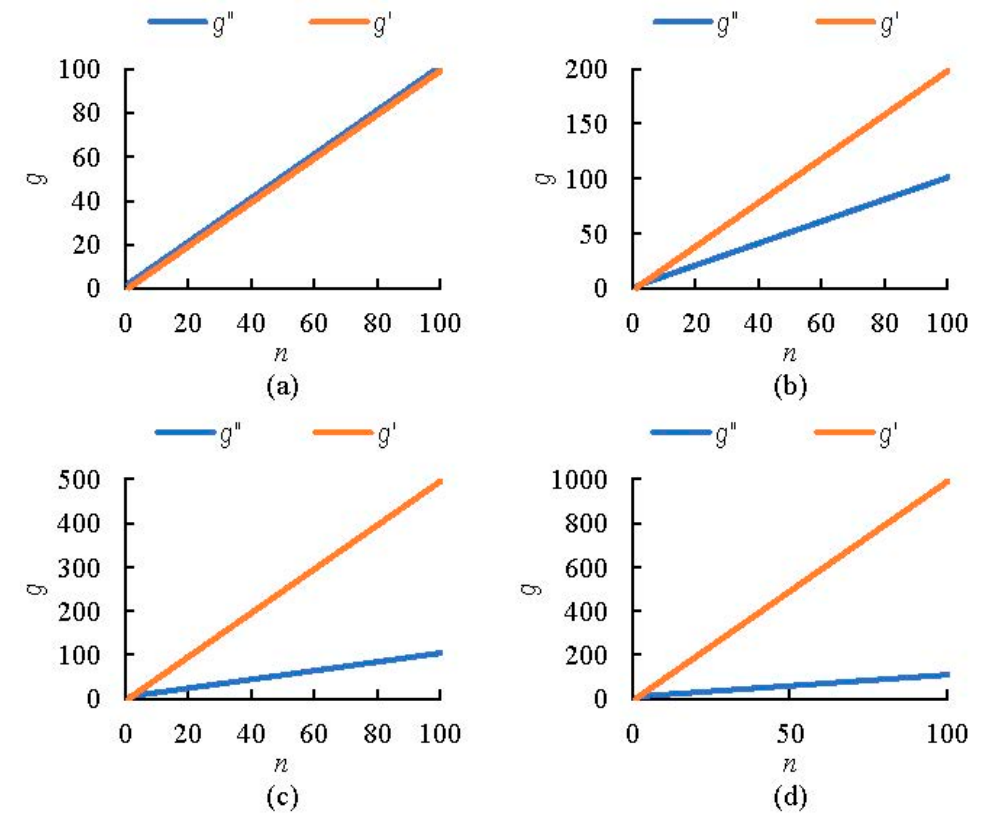
Figure 8. Comparison of the number of calibrations: ( a ) m =1, ( b ) m = 2, ( c ) m = 5, and ( d ) m = 10.